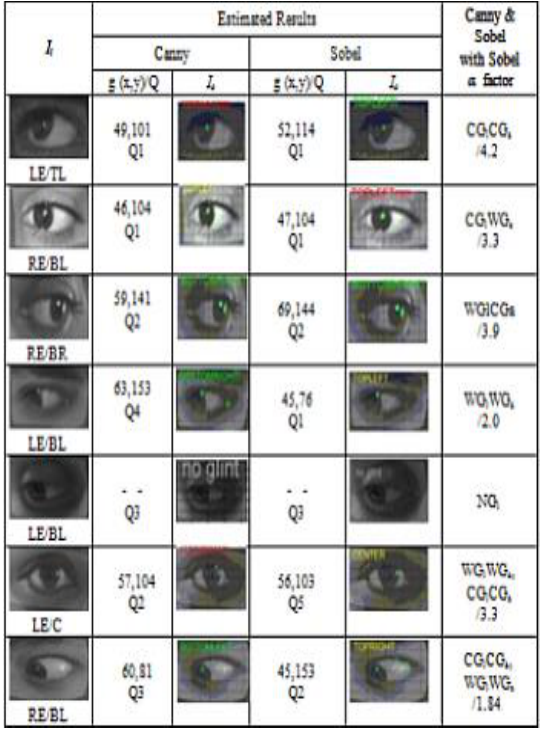
Table 1. Analysis of different one eye input images for the glint coordinates and direction quadrants identified by the proposed GDE